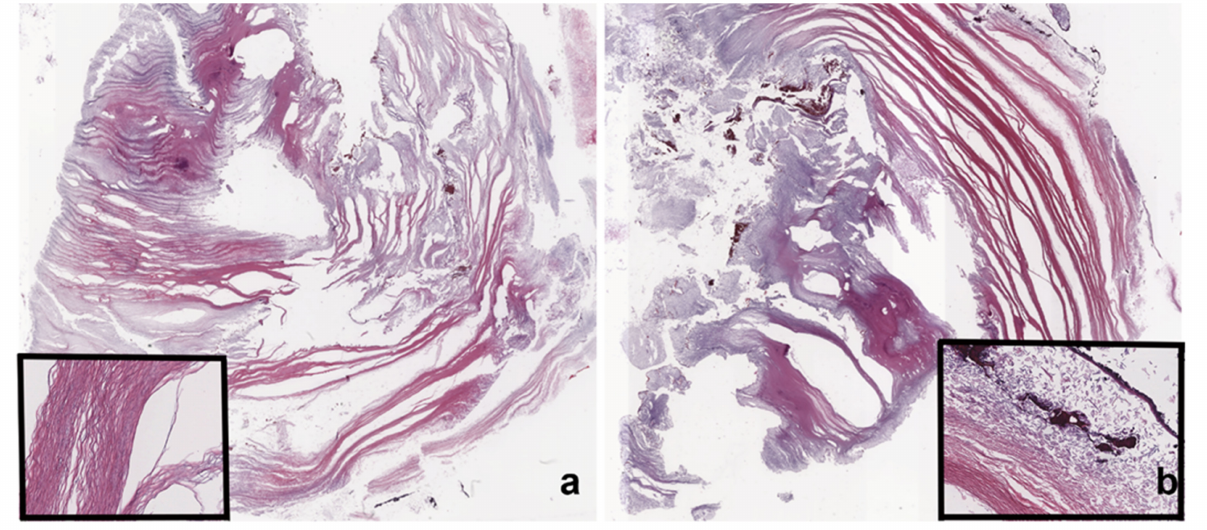
Figure 4. Case 3: the intracranial cyst was composed of squamous epithelia. In panels a and b , the sections show the lamellar keratin organization (highlighted in the insert in ( a ), keratin debris, and the absence of viable epithelium lining the thin wall of the cyst (insert in ( b ): wall inked by black China ink). Hematoxylin and eosin; ( a , b ) original magnification 1 × ; inserts in ( a , b ) original magnification 200 ×